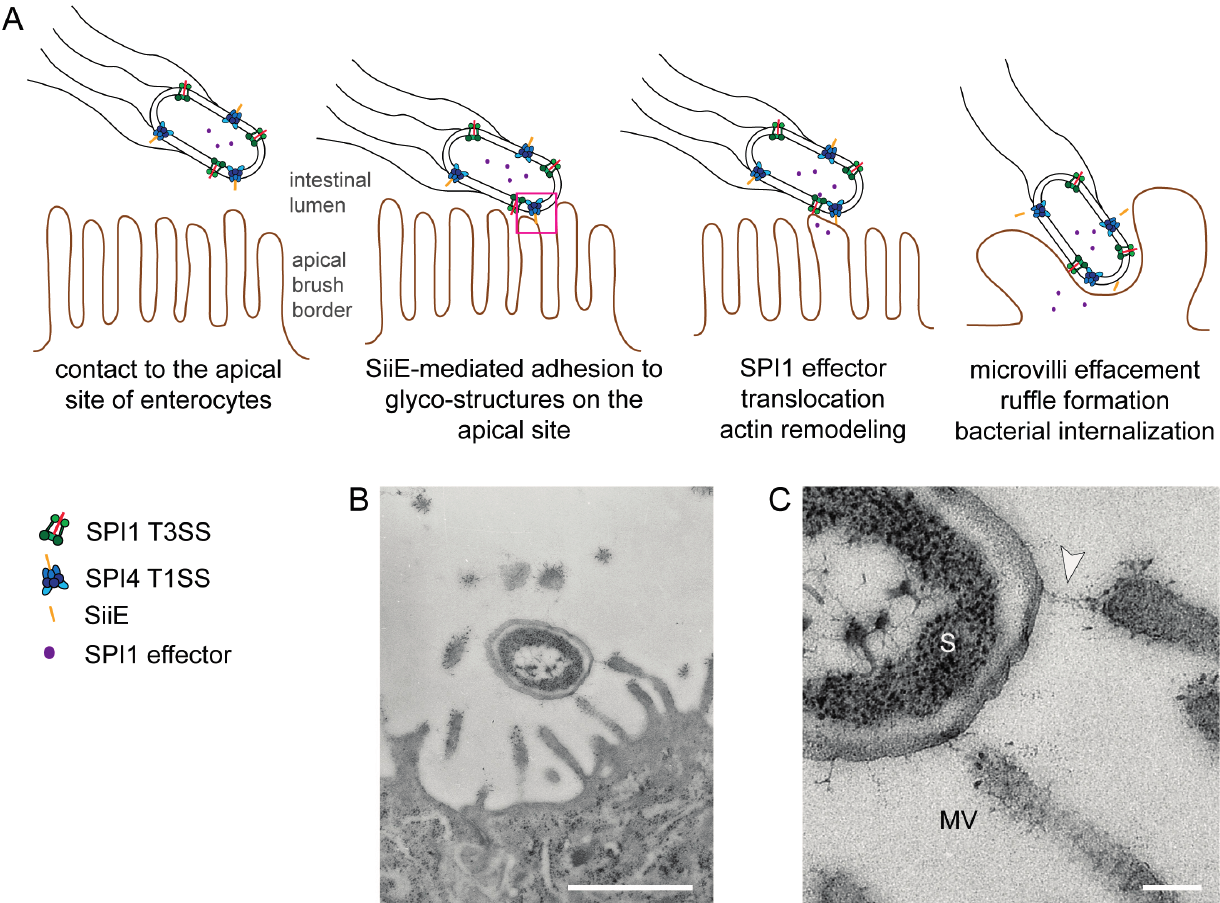
Figure 1. Model for the cooperation of the Salmonella Pathogenicity Island 4-encoded type I secretion system (SPI4-T1SS) and the Salmonella Pathogenicity Island 1-encoded type III secretion system (SPI1-T3SS) during invasion of polarized cells by S. enterica . ( A ) The apical side of polarized epithelial cells has a dense array of microvilli (i); The SPI4-encoded T1SS secretes SiiE that mediates adhesion and intimate contact of Salmonella to the apical membrane (ii); This close contact is required for the efficient translocation of the effector proteins by the SPI1-T3SS (iii); SPI1-T3SS effector proteins remodel the host cell actin cytoskeleton, resulting in formation of membrane ruffles and internalization of Salmonella and in the effacement of the brush border (iv). In the absence of the SPI4-T1SS and the adhesin SiiE, contacts between bacteria and host cells are highly reduced and translocation of SPI1-T3SS effectors is inefficient. Consequently, these mutant strains are severely compromised in host cell entry from the apical side (adopted from [5]); ( B , C ) Ultrastructure of Salmonella interaction with the apical side of MDCK cells during infection. Infection of the apical side of MDCK cells was performed using a MOI of 10, cells were fixed 30 min post infection and further processed for transmission electron microscopy (TEM). Close up view of the contact site between Salmonella and the host cell. The arrowhead indicates a putative SiiE-mediated connection. S = Salmonella , MV = microvillus. Scale bars, 1 µm (B), 100 nm (C). Reproduced, with permission, from Ref.